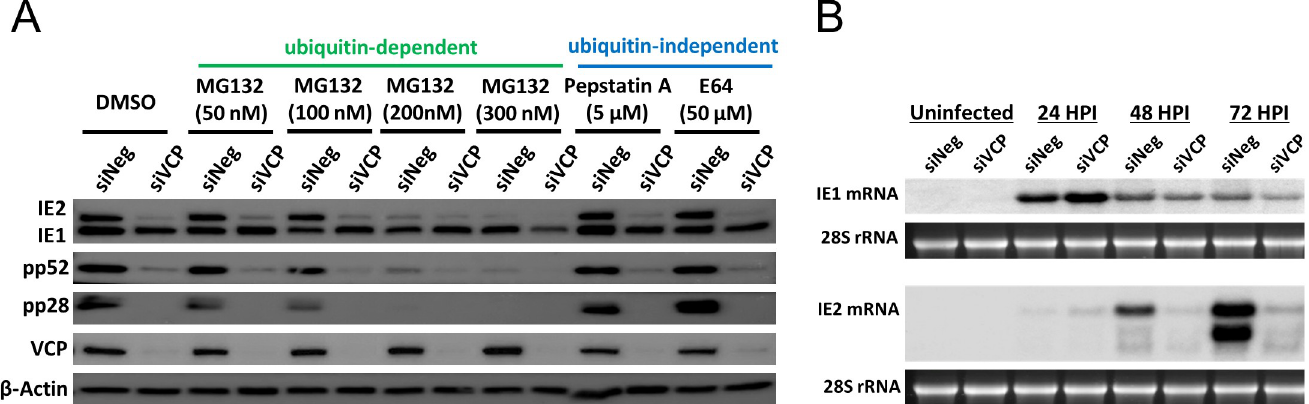
Fig 4. Knockdown of VCP results in substantial reduction in IE2 transcript. (A) Followingtransfectionwith VCP siRNA or negativecontrol siRNA, cells were treated with proteasome or protease inhibitors, then infected with HCMV. Viral protein levels were measuredby western blot analysis. Inhibitionof protein degradation did not rescue IE2 expressionin VCP knockdown cells. (B) Fibroblast cells were transfected with VCP or negative control siRNA and infected with HCMV. Total RNA was harvestedat the indicatedtime points and IE1 and IE2 transcript levels determined by Northern blot analysis. 28S rRNA stainedwith ethidium bromide is shown as loadingcontrol.